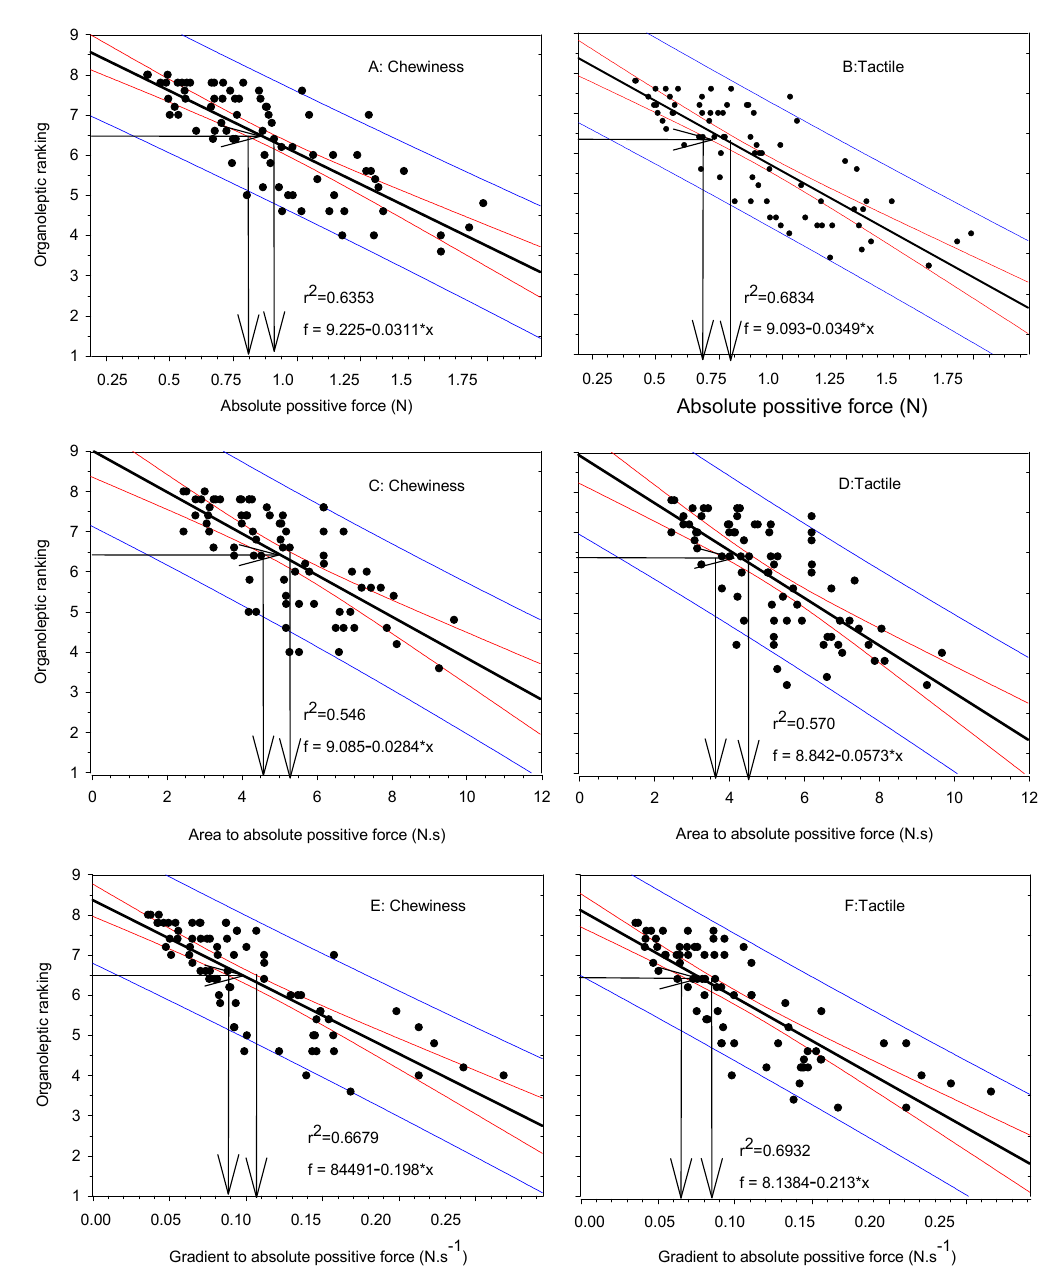
Figure 2. Correlation of APF (absolute positive force, ( A , B )), AAPF (area to absolute positive force, ( C , D )), and GAPF (gradient to absolute positive force, ( E , F )) values to organoleptic chewiness and tactile firmness, respectively, of total lentil seed samples during cooking at 100 °C for 20–60 min. Black lines in bold represent the curve fitting according to linear model, red lines represent the 95% confidence intervals, and blue lines represent the prediction intervals. Arrows indicate the threshold range of the seeds, from soft to optimum cooking quality.